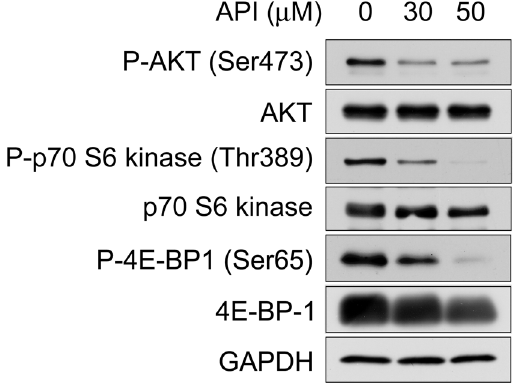
Figure 9. Apigenin-mediated down-regulation of β -catenin is through inhibition of the AKT/mTOR signaling pathway. HCT-116 cells were treated with different concentrations of apigenin (0, 30 and 50 μ M) for 20 h, and the protein expression of phospho-AKT (Ser473), AKT, phospho-p70 S6 kinase (Thr389), p70 S6 kinase, phospho-4E-BP1 (Ser65), and 4E-BP1 was examined by Western blotting analyses with the antibodies respectively. GAPDH serves as a loading